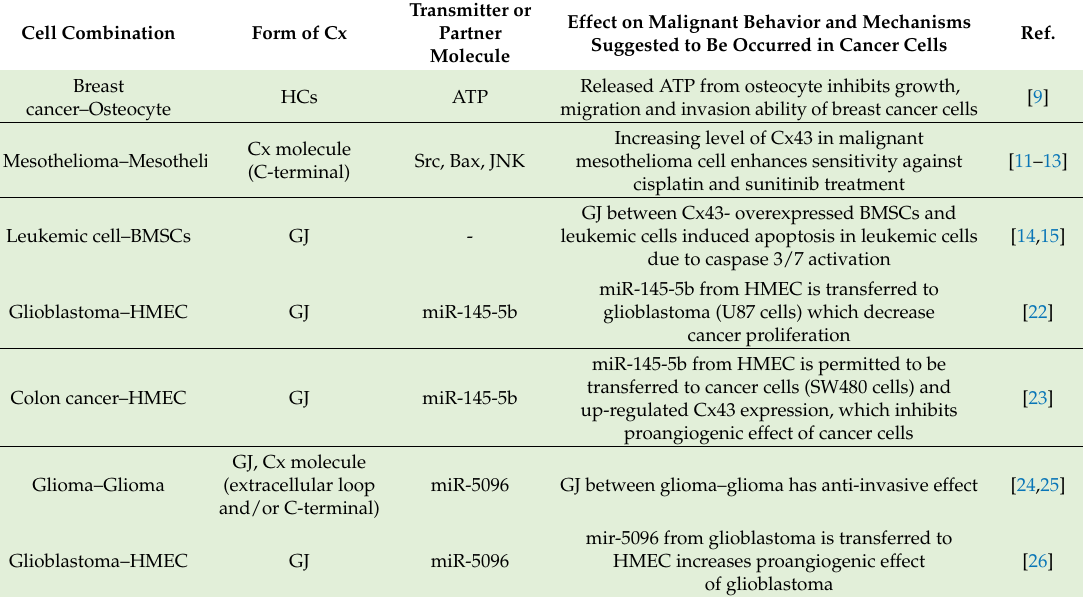
Table 1. Summary of the role of Cx43 with specific cell combinations in cancer